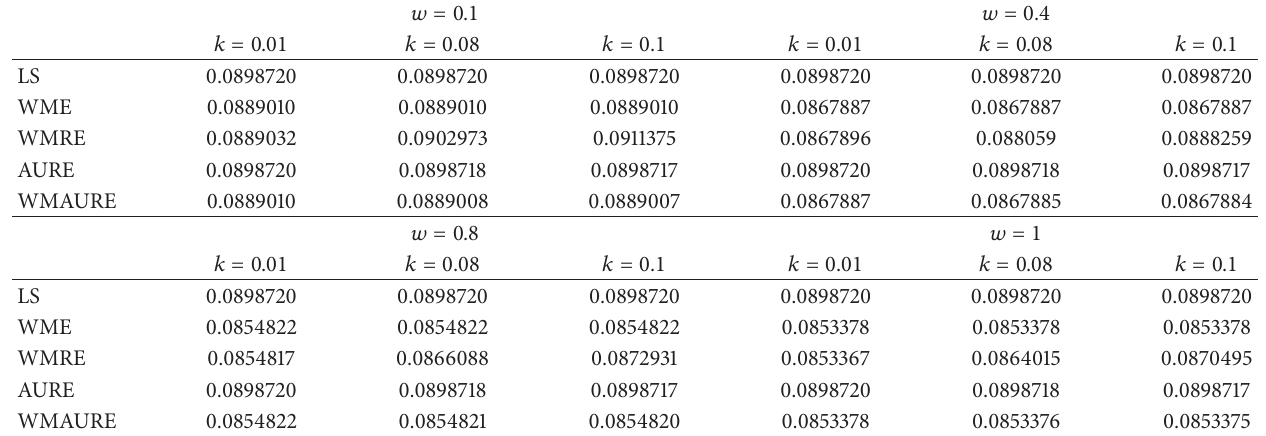
Table 3: Estimated MSE values of the WME, WMRE, AURE, and WMAURE when 𝜌 = 0.8 .